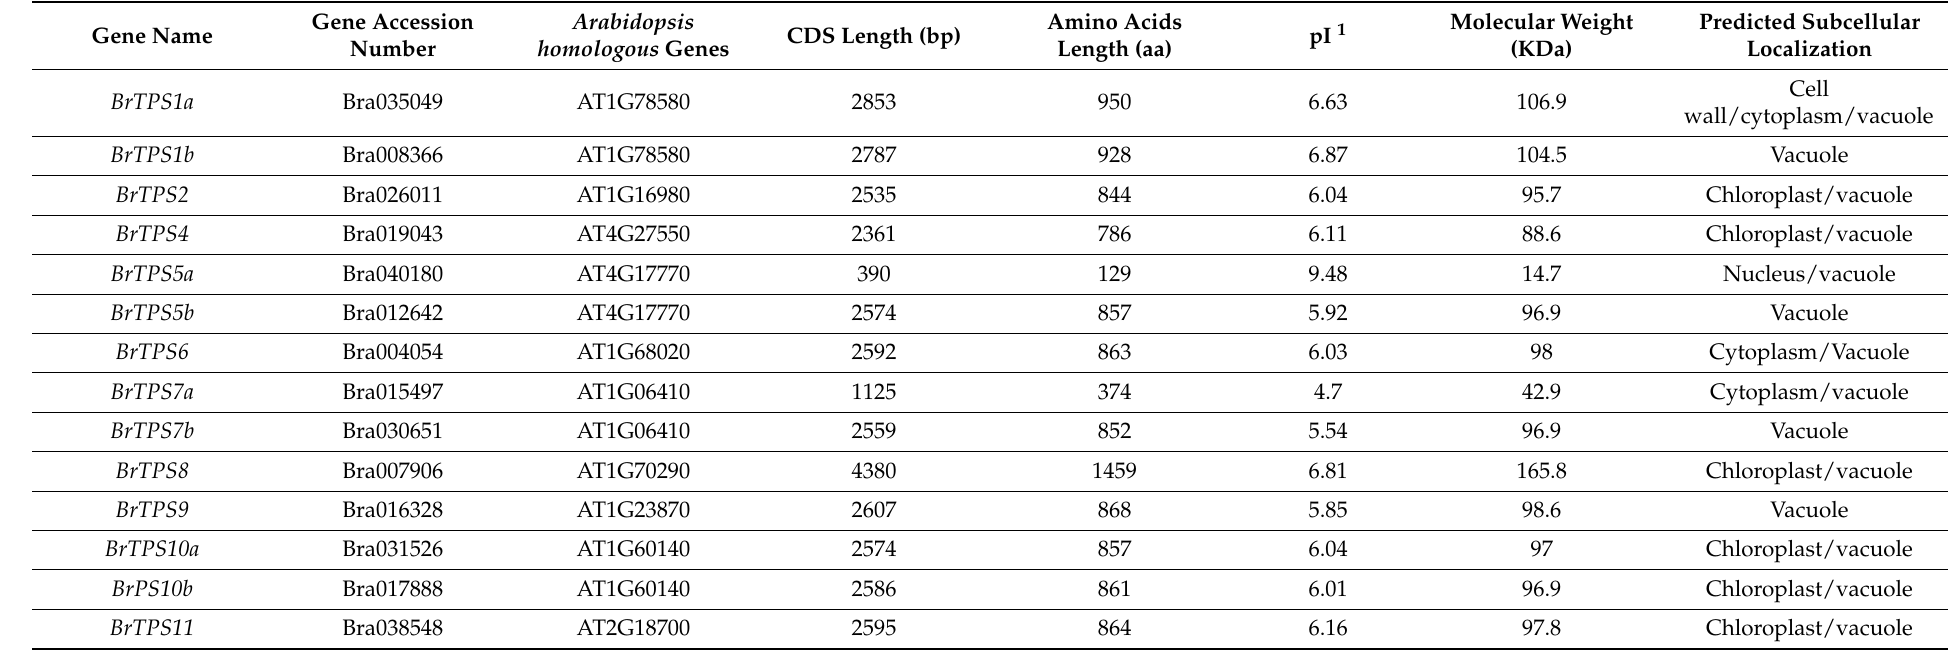
Table 1. The information of TPS genes in B. rapa .